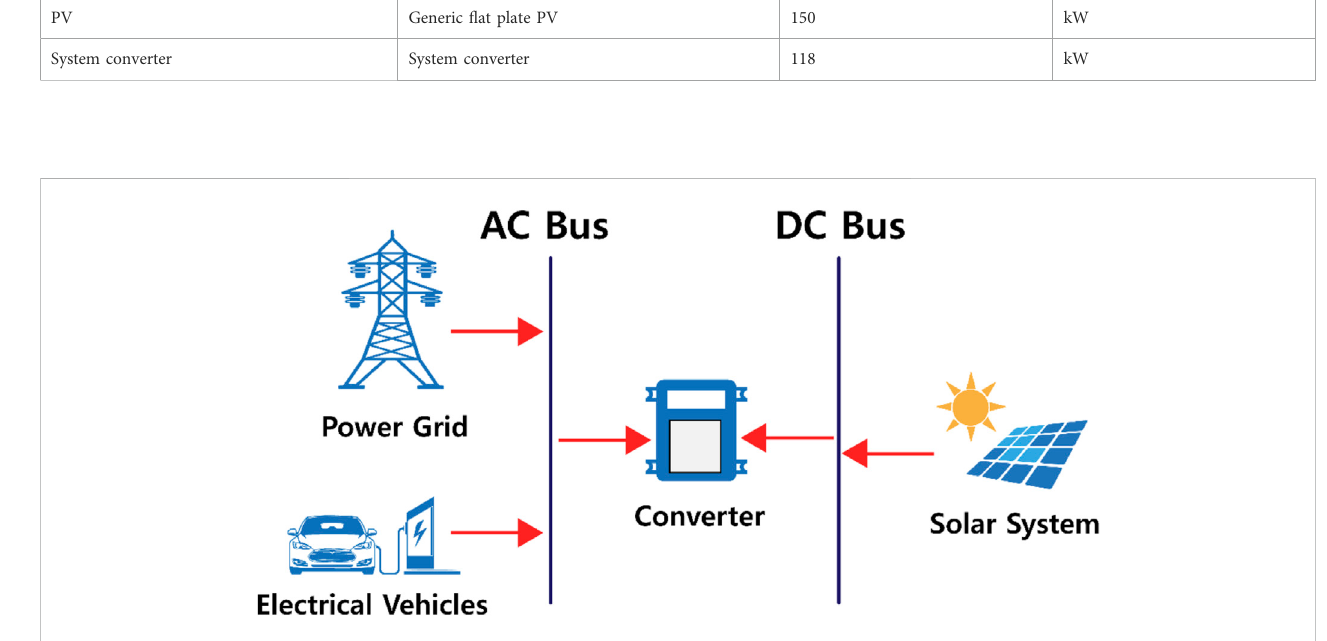
FIGURE 4 System model of the proposed